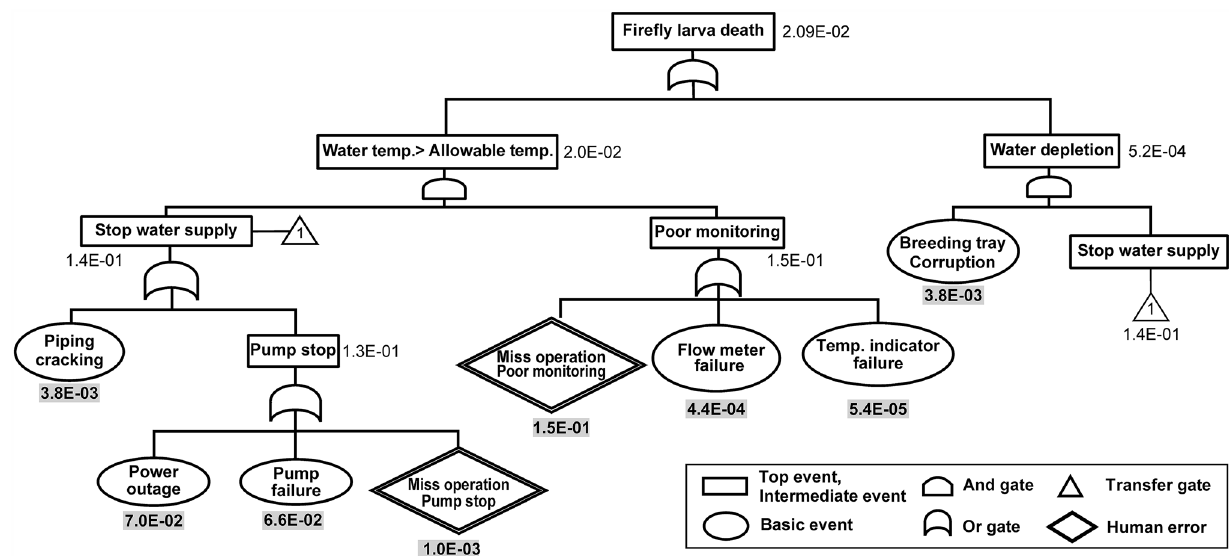
Fig. 2 FTA for firefly larval